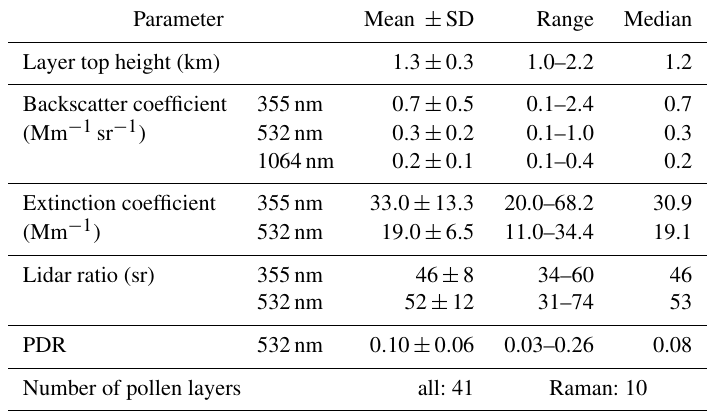
Table 1. Mean values, range and median of optical properties of the detected pollen layers in the first measurement period: 5–10 May, intense birch pollination period.